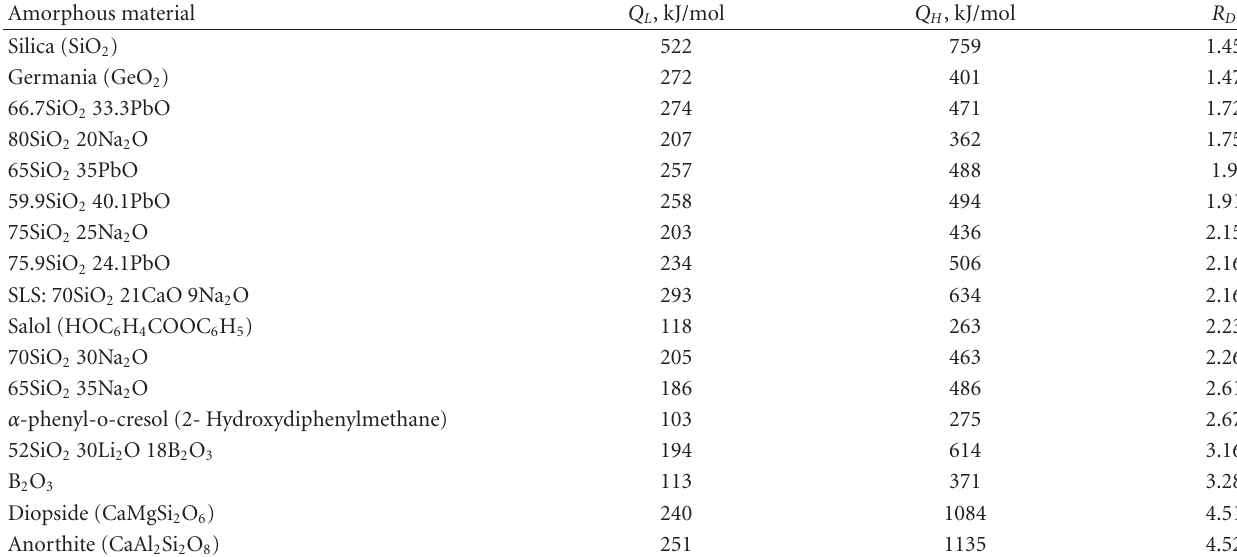
Table 3: Asymptotic Arrhenian activation energies for viscosity and the corresponding Doremus fragility ratios [47]. Amorphous material Q L , kJ/mol